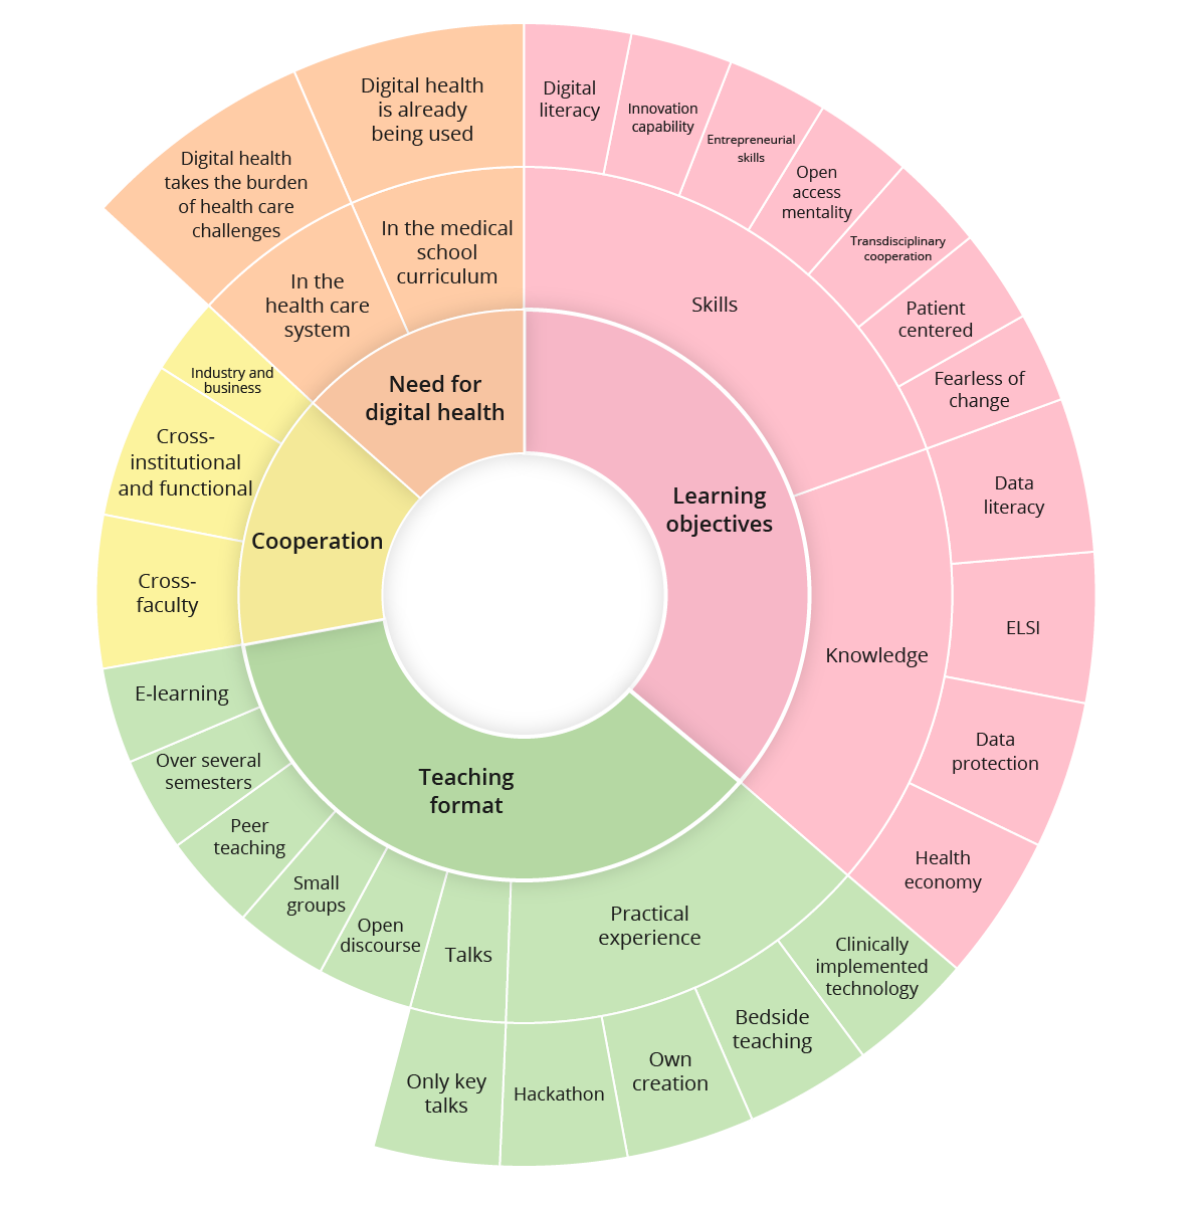
Figure 1. This sunburst diagram represents the qualitative results. Within the 4 themes (inner ring), subthemes (middle ring) are assigned and specified (outer ring). ELSI: ethical, legal, and social